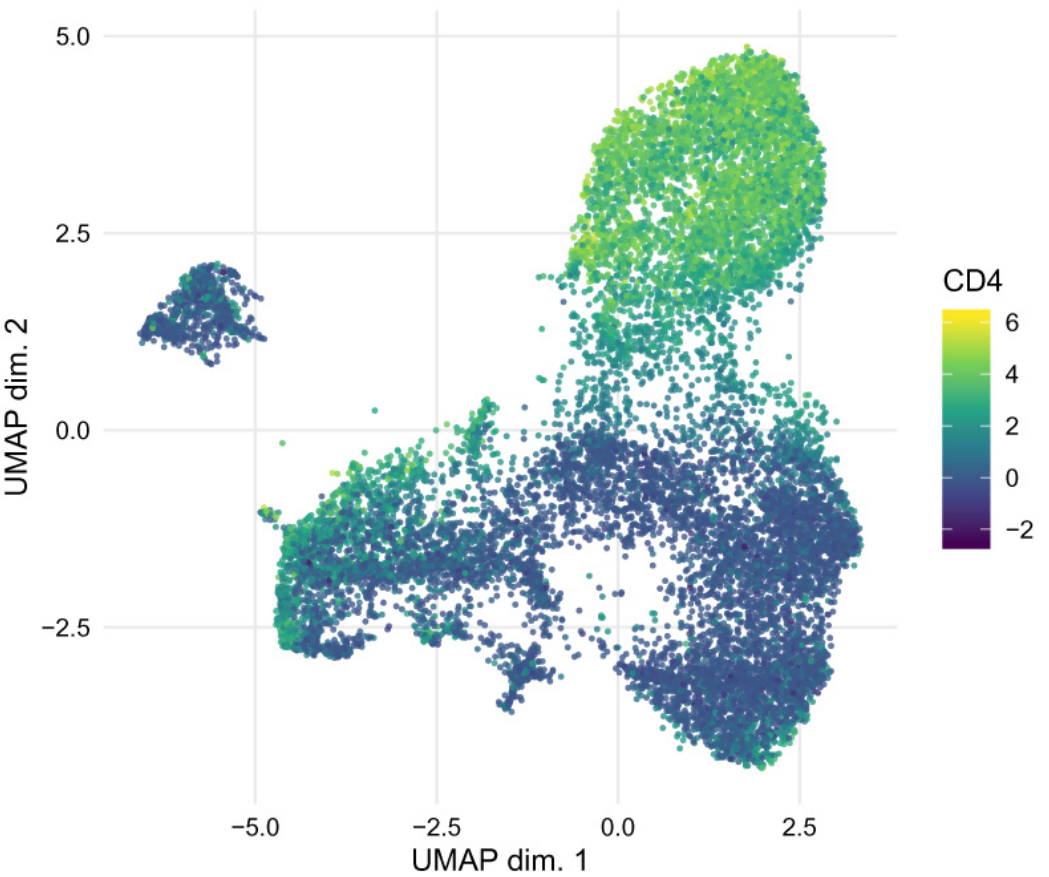
Figure 9. UMAP based on the arcsinh-transformed expression of the 10 lineage markers in the cells from the PBMC dataset. UMAP was run with no PCA step. From each of the 16 samples, 1000 cells were randomly selected. Cells are colored according to the expression level of the CD4